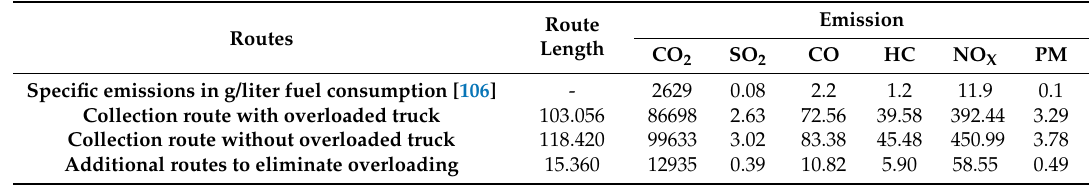
Table 4. Calculated emission of collection routes.